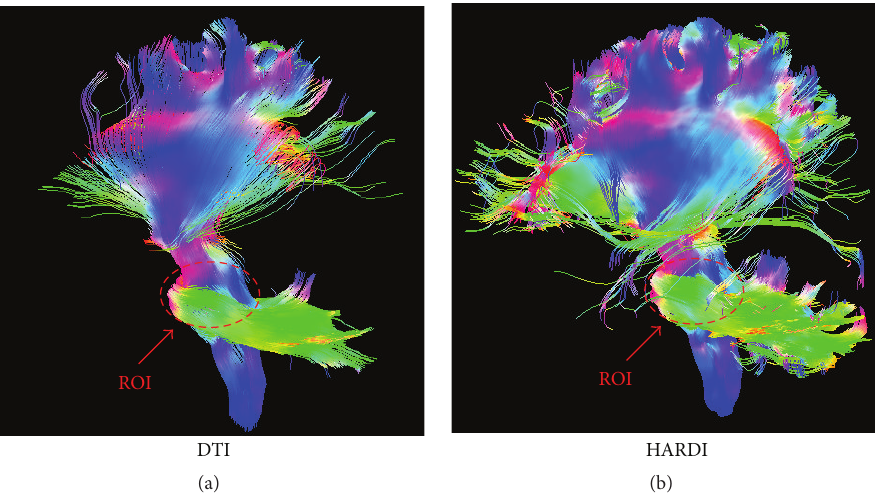
Figure 2: Tractography results based on a seed ROI at the brain stem with (a) the DTI method and (b) the HARDI method.